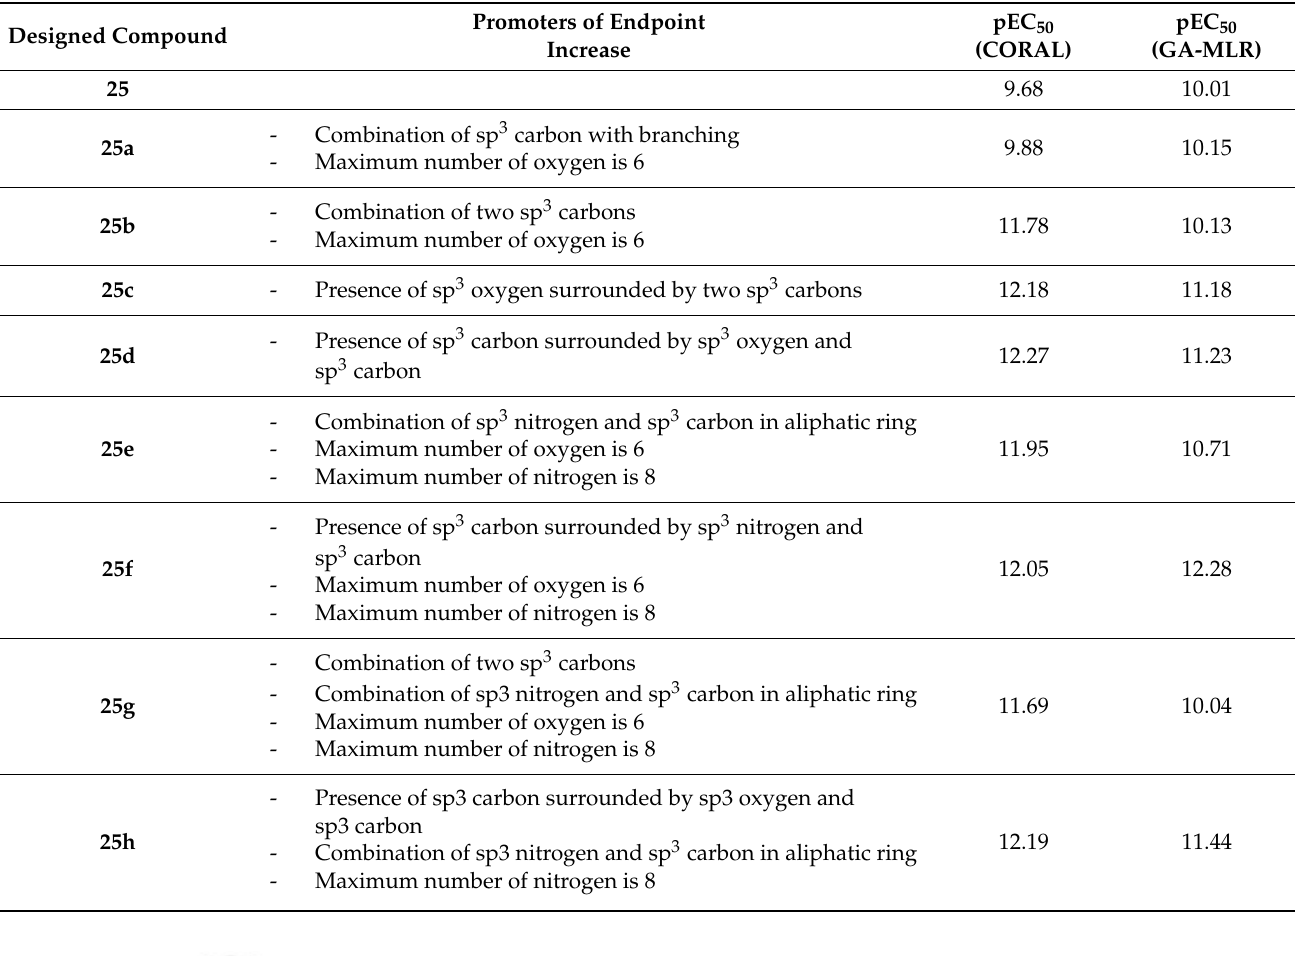
Table 3. The newly designed compounds and their predicted pEC 50 using the Monte Carlo optimiza- tion and the GA-MLR models.